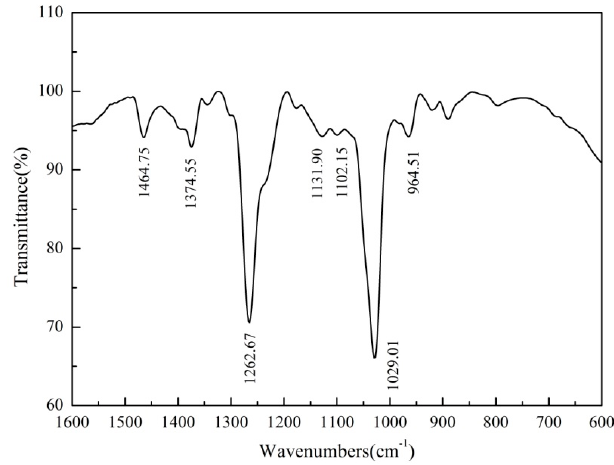
Figure 12. FTIR spectra of pyrrhotite after reacting with mixed collector (NaBX + (BX) 2 ) at pH = 6.